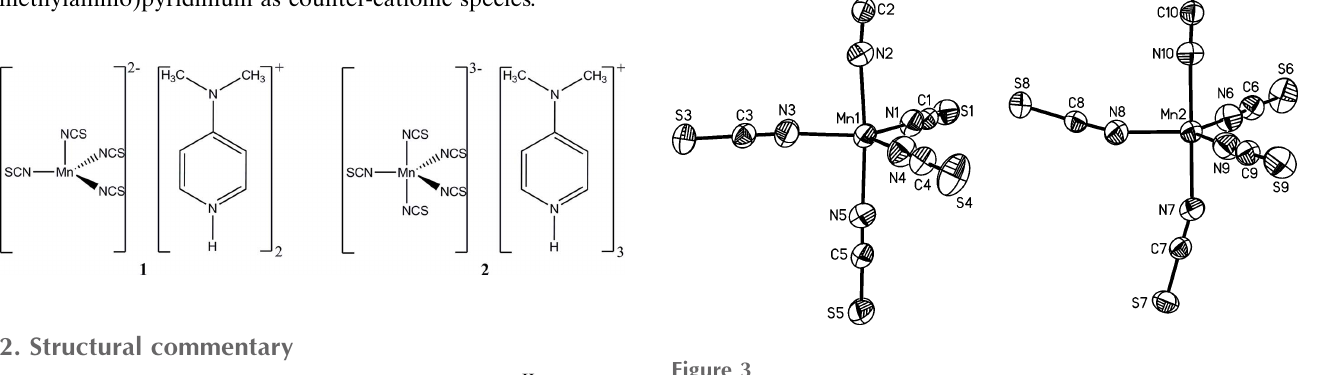
Figure 3 View of the Mn coordination in 2 , with atomic labelling and displacement ellipsoids drawn at the 50% probability level.